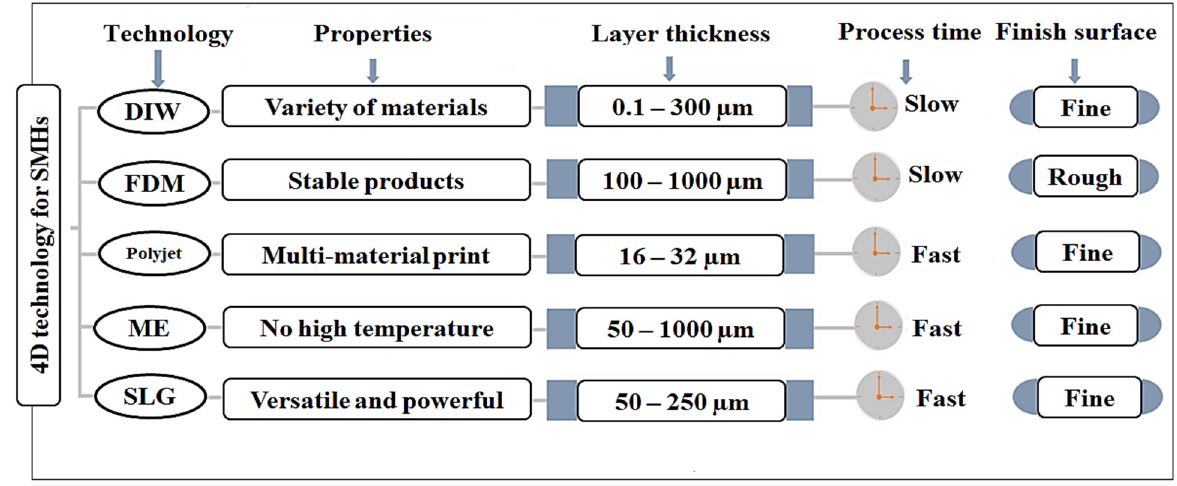
Figure 4. Illustration of various 4D hydrogel fabrication techniques, surface properties, process time, and layer thickness of 4D constructs. DIW: Direct ink writing, FDM: Fusion deposition modeling, ME: Microextrusion, SLG: Stereolithography [111]. Table 5. A summary of comparison between 3D- and 4D-printing techniques [112,113].